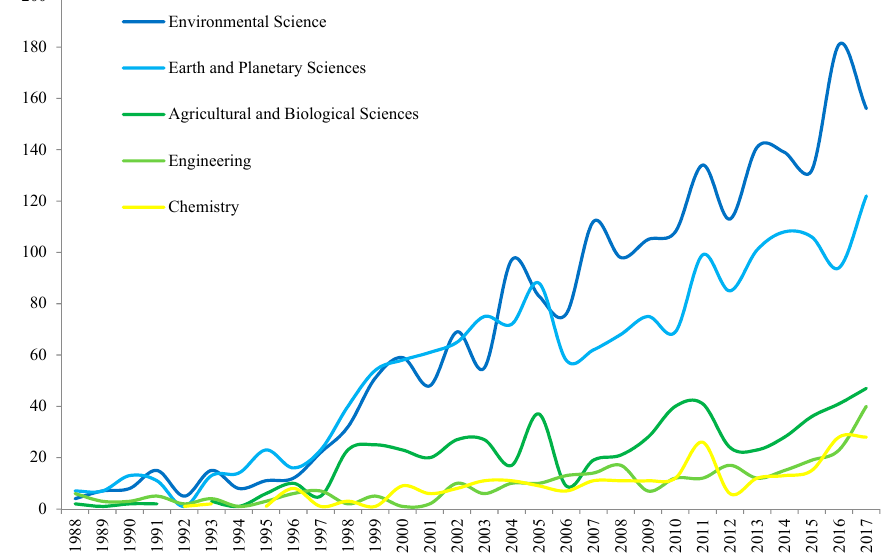
Figure 2. Trend in the subject categories of MW articles published from 1988 to